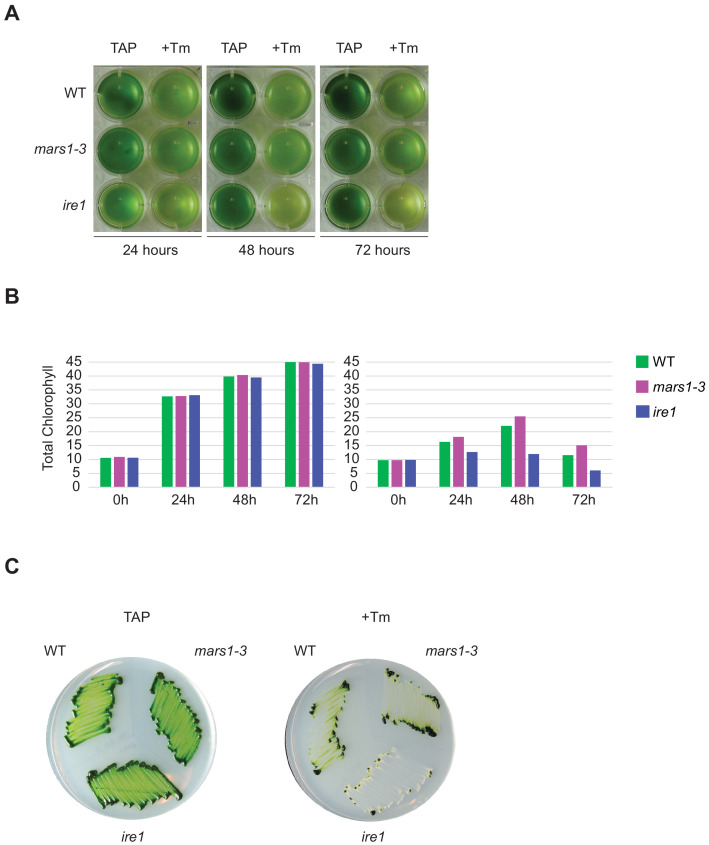
mars1 cells can cope with ER stress.(A) WT, mars1-3 and ire1 cells grown till log phase were harvested and resuspended to a final chlorophyll concentration of ~10 µg/ml in liquid TAP with or without 5 µg/ml of tunicamycin (Tm), a chemical ER stressor. Cultures were sampled at 24, 48 and 72 hr to take photographs and measure total chlorophyll concentration. ire1 cells were used as a positive control given the essential role of the Ire1 kinase in the activation of the erUPR (Yamaoka et al., 2018). (B) Histograms of total chlorophyll concentrations (µg/ml) measured from TAP liquid cultures collected during the experiment described in Figure 4—figure supplement 2A. (C) WT, mars1-3 and ire1 cells were streaked on TAP agar plates with or without 0.2 µg/ml of tunicamycin. Photographs were taken after 5 days of growth in normal light.